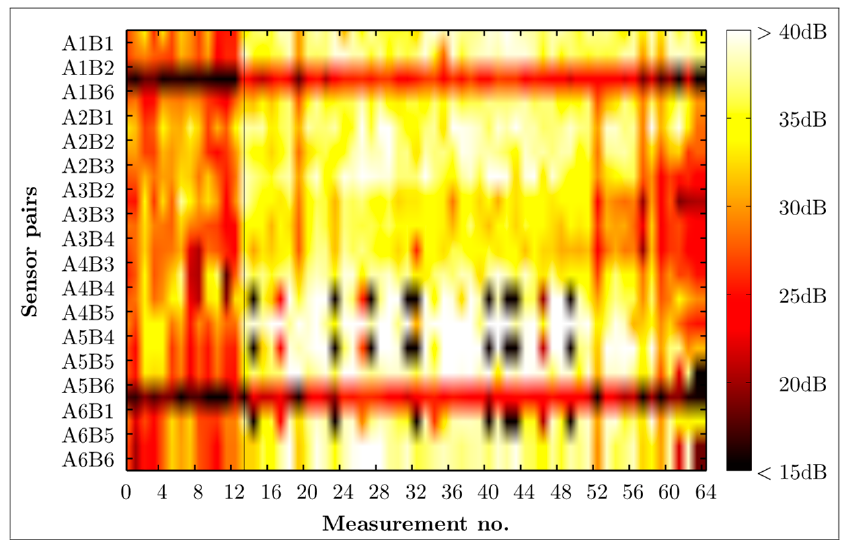
Figure 6. Matrix of SNR estimates for all transducer combinations in the AB layout AB. The vertical thin black line indicates the separation of Phase 1 and Phase 2 experimental tests.